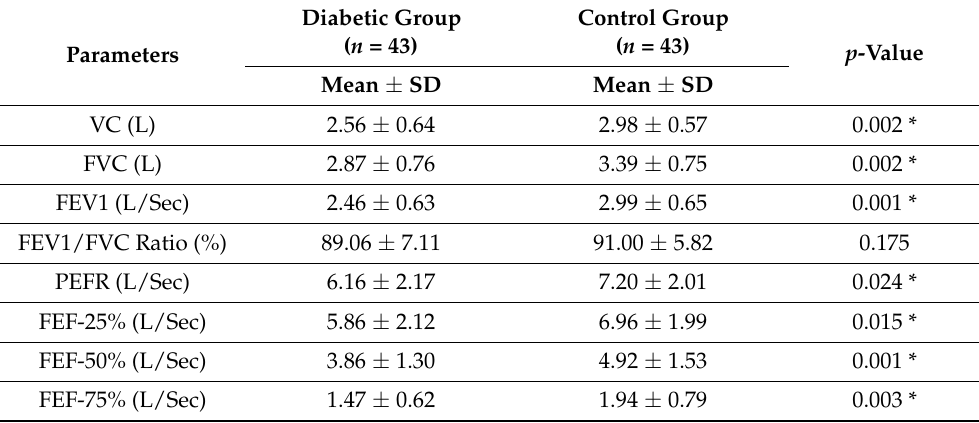
Table 6. Lung functions parameters for type 2 diabetic patients with HbA1c > 8 compared with their matched controls.